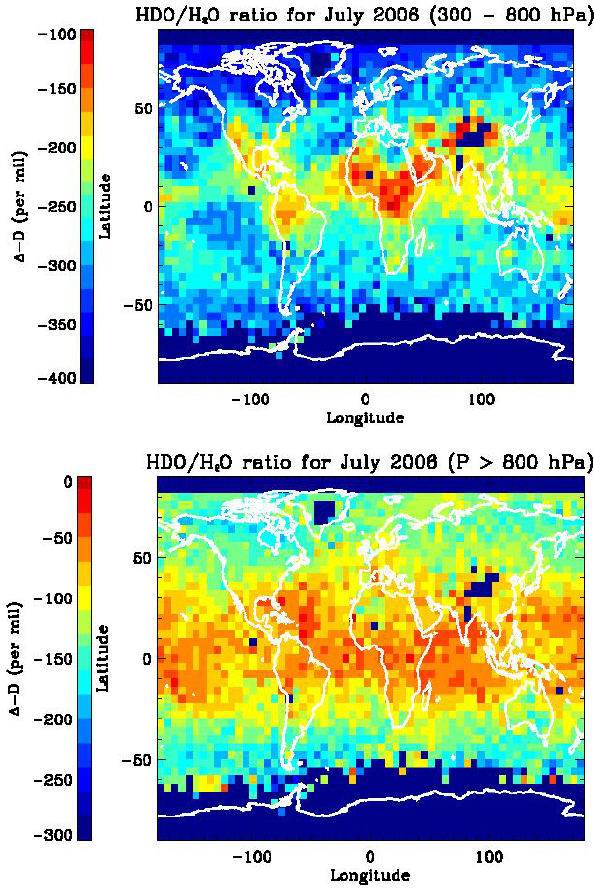
Fig. 6. (Bottom panel) Averaged TES HDO/H 2 O estimates for pres- sures greater than 800hPa. (Top panel) Averaged TES HDO/H 2 O estimates for pressures between 300 and 800hPa.